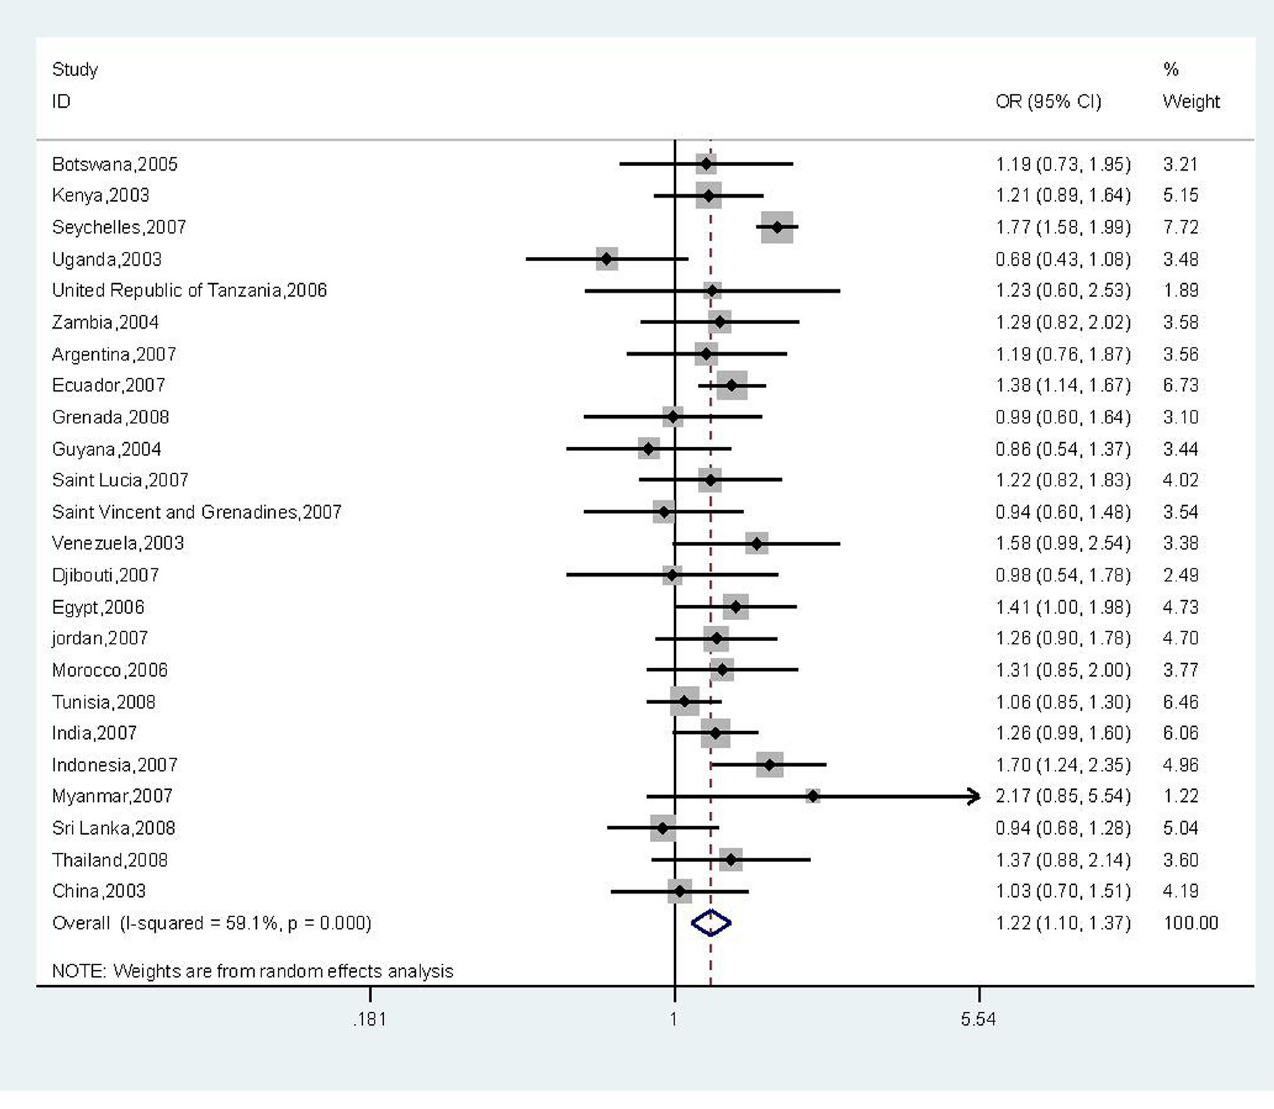
Fig 2. Association between > 2 h/d of sedentary behaviour and anxiety symptoms. Country-wise logistic regression models adjusted for age, sex, fruit and vegetable intake and physical activity, being bullied, smoking status(except for Sri Lanka, Venezuela, Egypt and Zambia) and alcohol intake (except for India, Djibouti, Egypt, Jordan, Tunisia and Sri